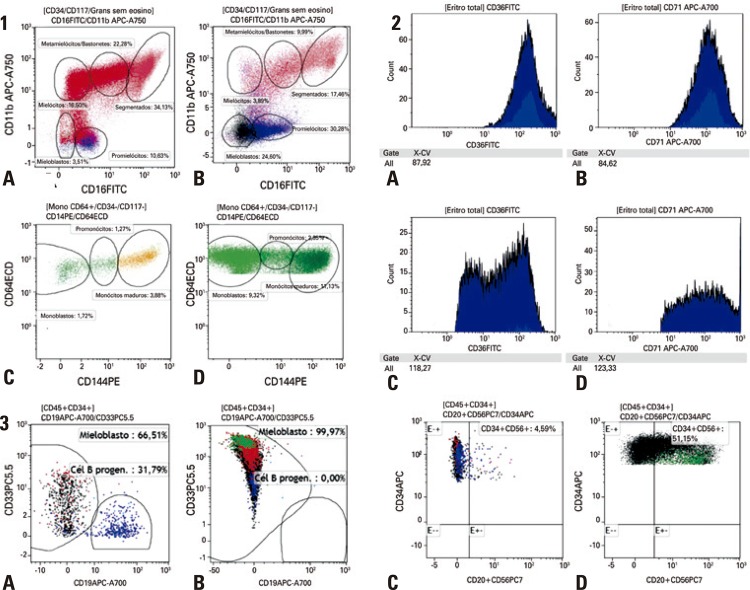
Examples of parameters evaluated by the multiline sheet. (1) Maturation curves of granulocytes and monocytes. (A) Normal maturation curve CD11b/CD16. (B) Maturation curve with an increase in myeloid precursors and decrease of the more mature forms. (C) Normal maturation curve of monocytes. (D) Maturation curve with increased number of monoblasts and promonocytes. (2) Evaluation of the erythroid series. (A) Normality standard for the coefficient of variation of CD36. (B) Normality standard for the coefficient of variation of CD71. (C) Coefficient of variation of CD36 above the normalcy values. (3) Parameters for the evaluation of progenitor cells. (A) Normal distribution of the progenitor cells among the myeloblasts and B-cell progenitors. (B) Increase in myeloblasts and decrease in B-cell progenitors. (C) Normalcy with negative expression of CD56 in CD34 cells. (D) Anomalous expression of CD56 in CD34+ cells